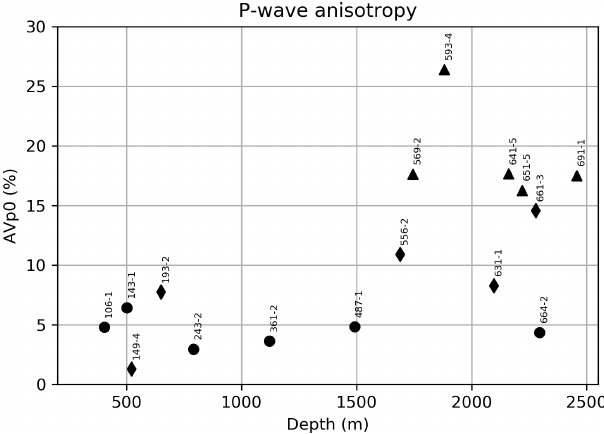
Figure 8. Mean intrinsic velocity measured in 16 core samples from the COSC-1 borehole plotted at the respective sample depth. Markers correspond to simplified lithological classes such as mafic amphibole-rich units ( (cid:7) ), felsic gneisses and metasandstone ( • ), and mica schist ( (cid:78) ). Note that the highest values occur for the mafic lithologies.